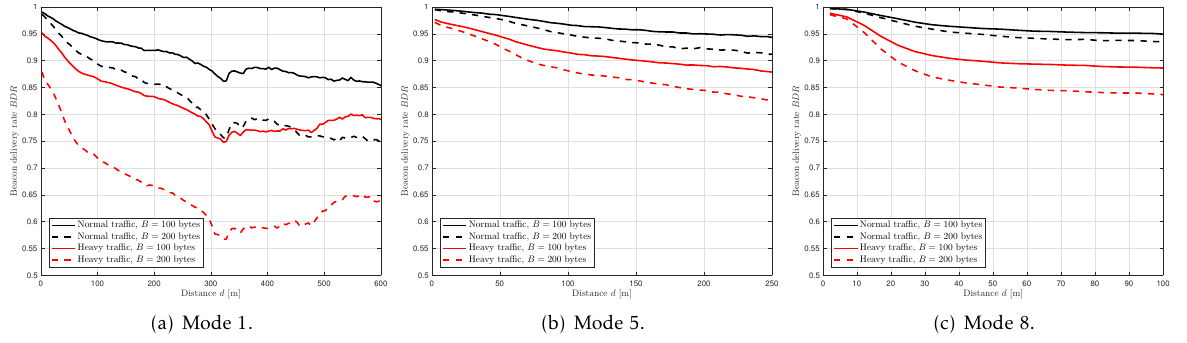
Figure 2. LOS beacon delivery rate vs. transmitter-receiver distance for selected Modes.